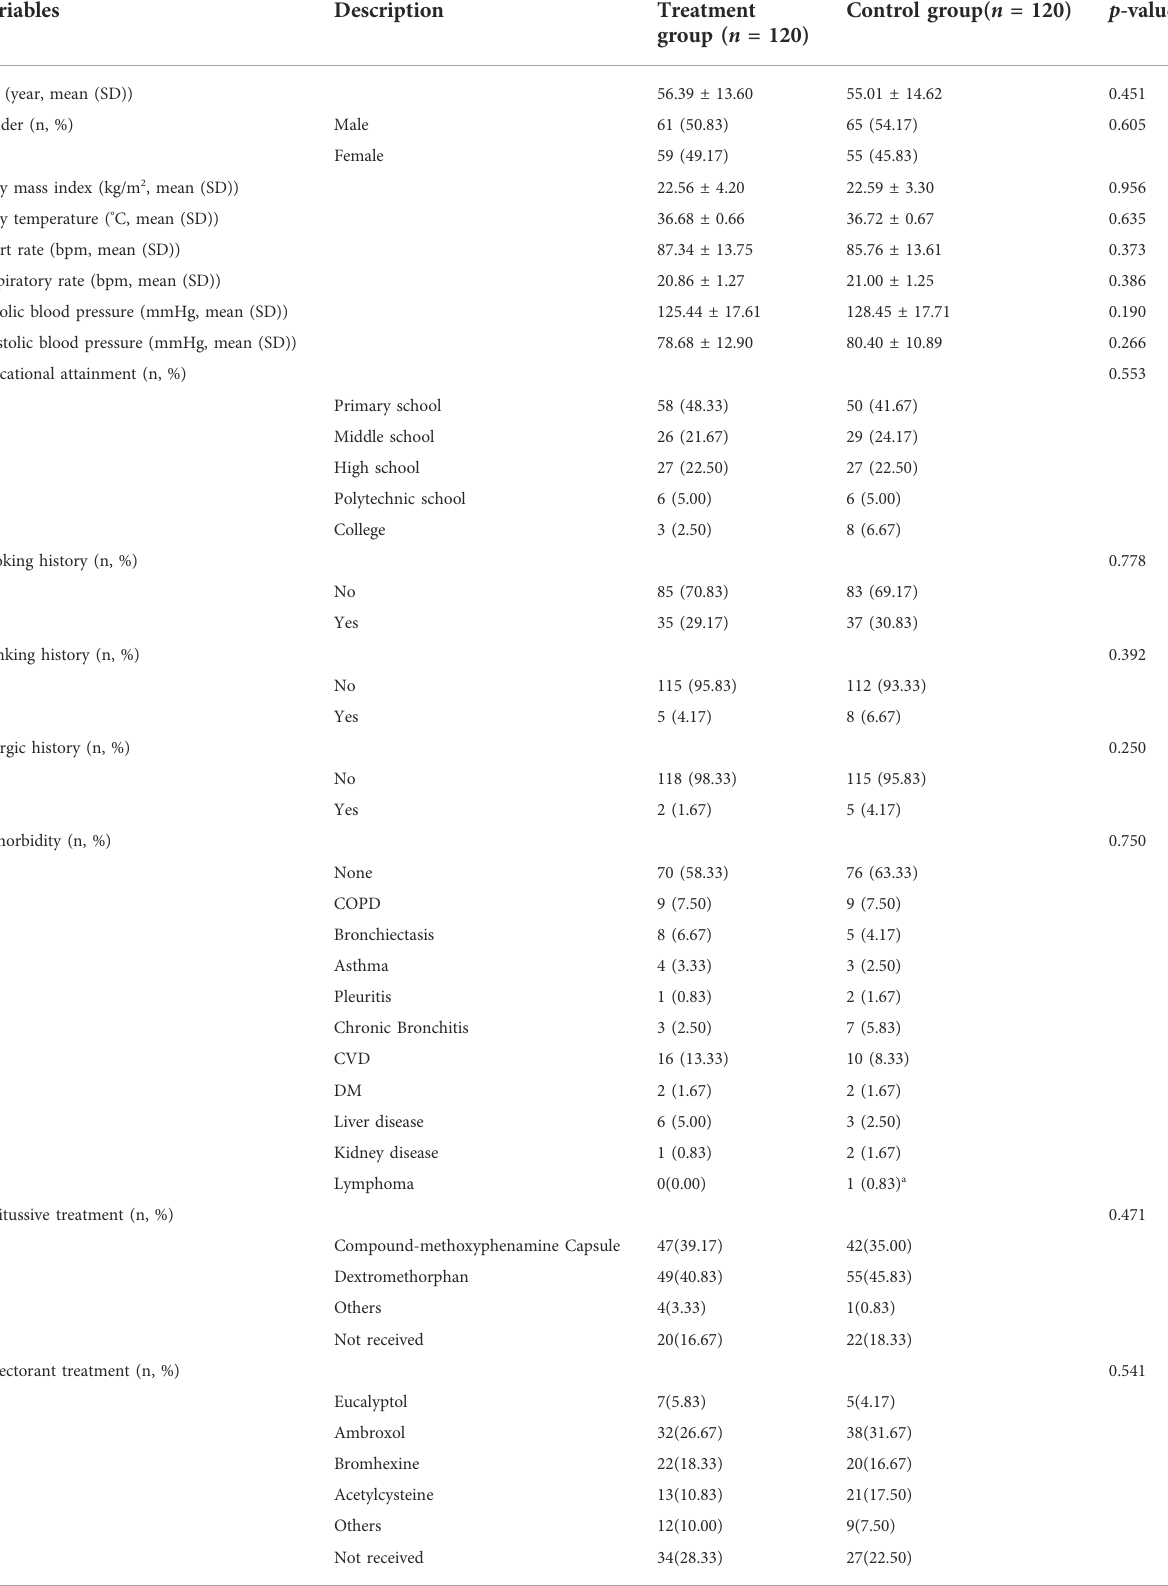
TABLE 1 Baseline demographic and clinical characteristics of the patients from